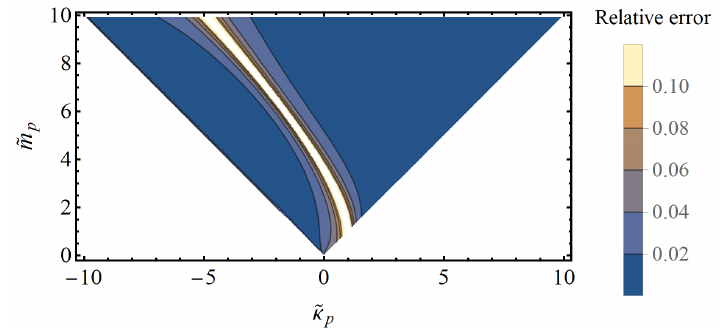
Figure 11 . The relative error of the O ( (cid:15) ) empirical formula (4.38) as compared to the numeric result. The bright band cutting across the plot is where the O ( (cid:15) ) correction crosses zero, hence the large relative